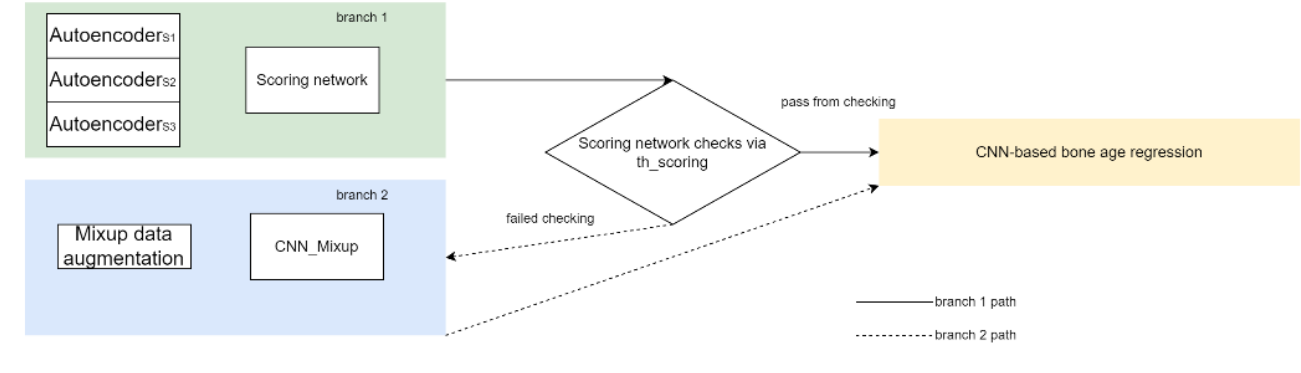
Figure 2. Framework of DAIIBAA.